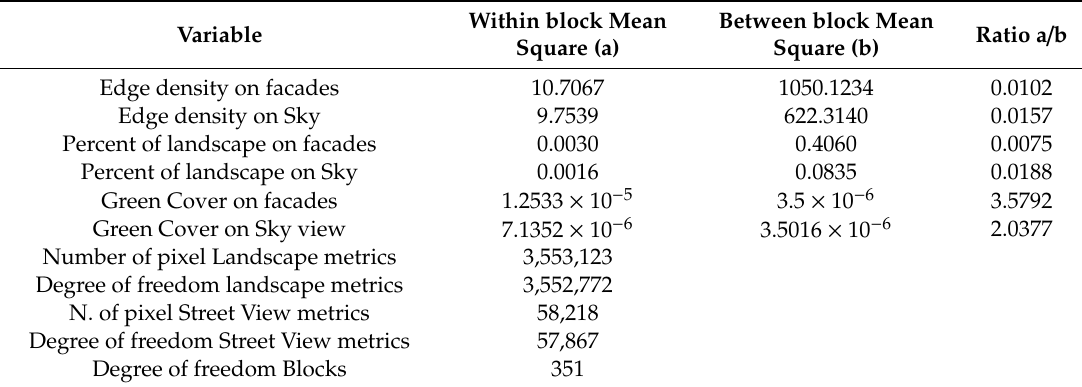
Table 2. Statistics of metrics within and between the